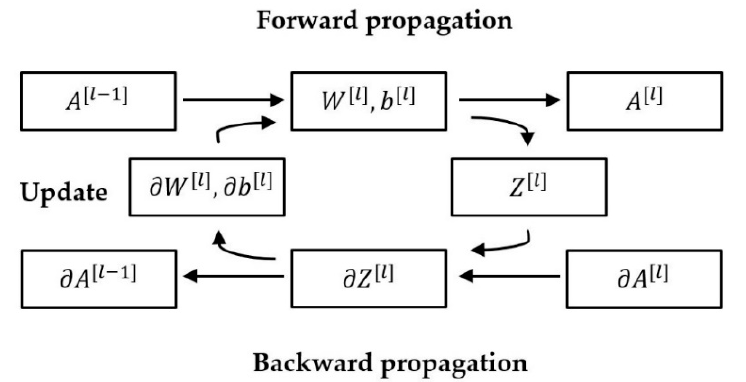
Figure 1. Schematic description of the operation of the neural network in layer l .